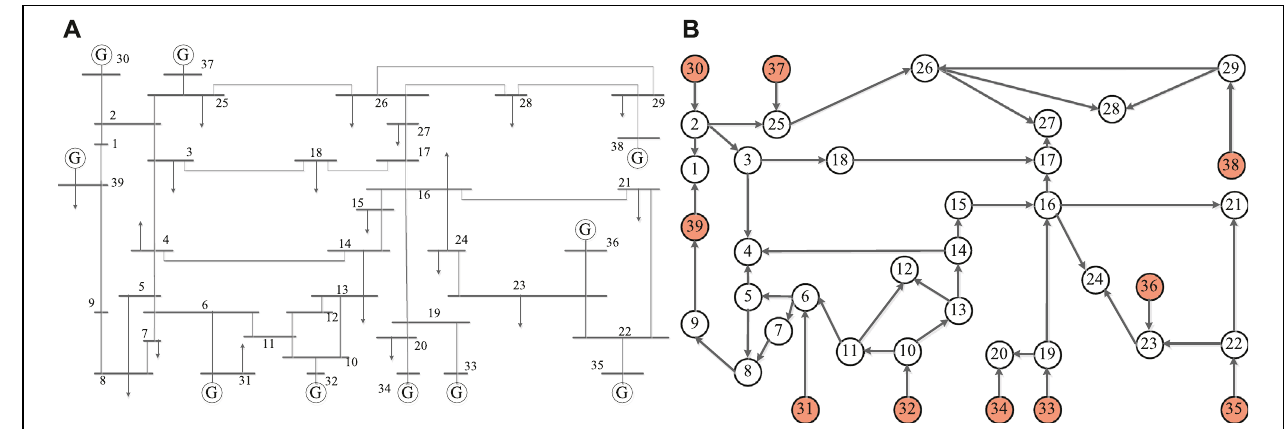
FIGURE 5 | (A) Wiring diagram of IEEE 39 bus system; (B) Network model of IEEE 39 bus system. The red nodes are generator nodes.